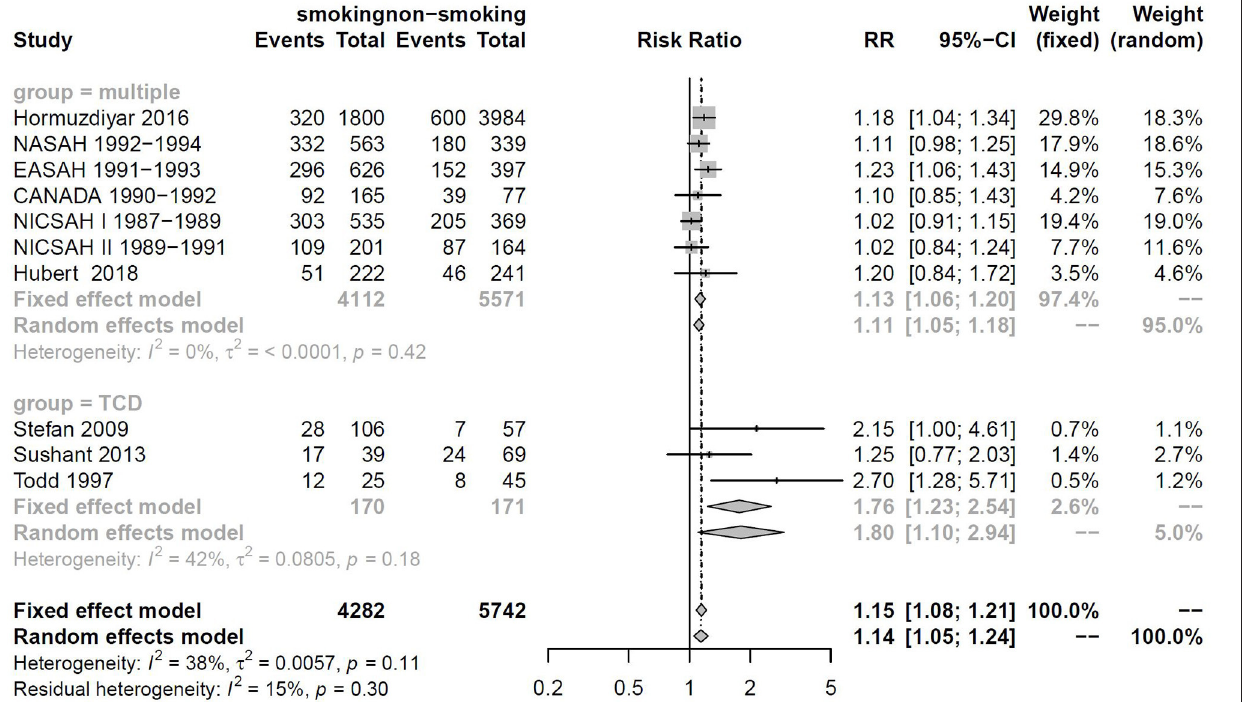
FIGURE 5 | Forest plot of subgroup analysis by the DCI measurement method.